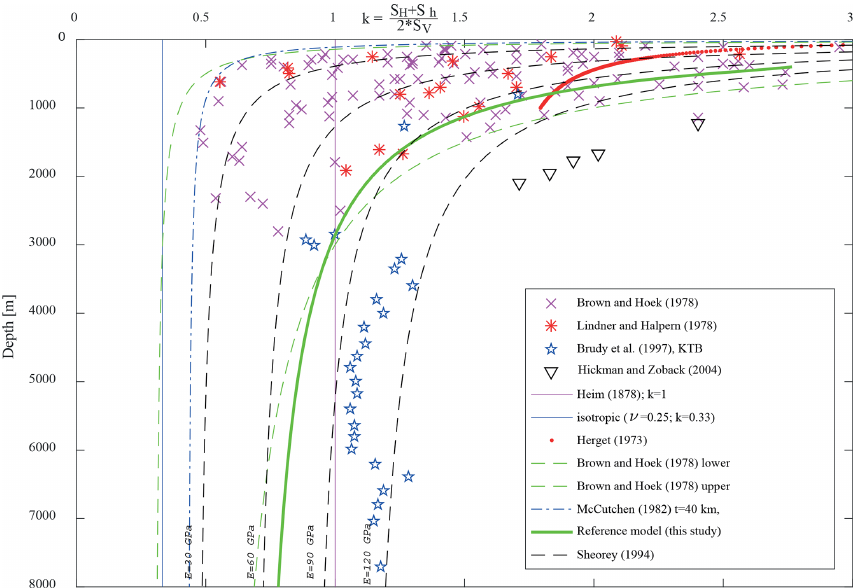
Figure 4. The stress ratio k (Eq. 3) is plotted vs. depth. Stress in the reference model is marked with the bold green line. Additionally, several data and defined stress ratios from the literature are visualized for comparison (Heim, 1878; Herget, 1973; Brown and Hoek, 1978; Lindner and Halpern, 1978; McCutchen, 1982; Sheorey, 1994; Brudy et al., 1997; Hickman and Zoback, 2004).